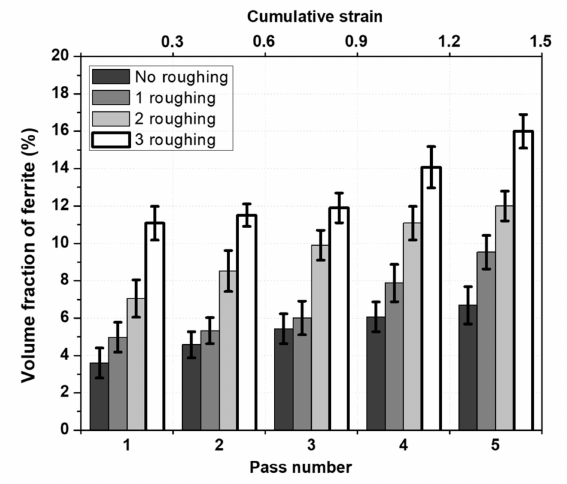
Figure 9. Volume fraction of ferrite formed per pass. The amounts of ferrite increase with pass number and were even favored by the number of roughing